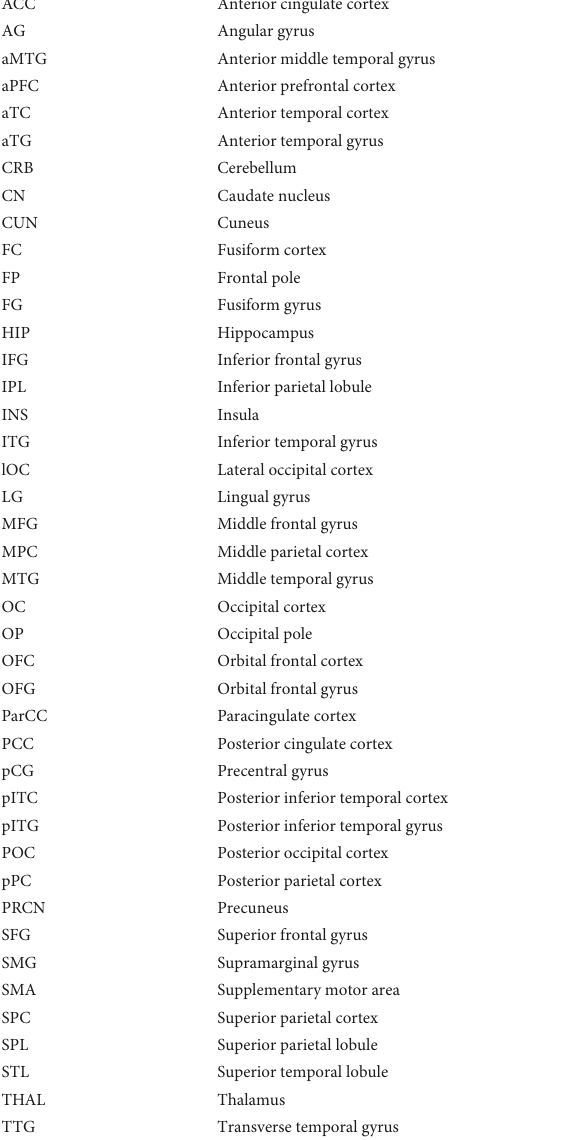
TABLE 5 Abbreviations of